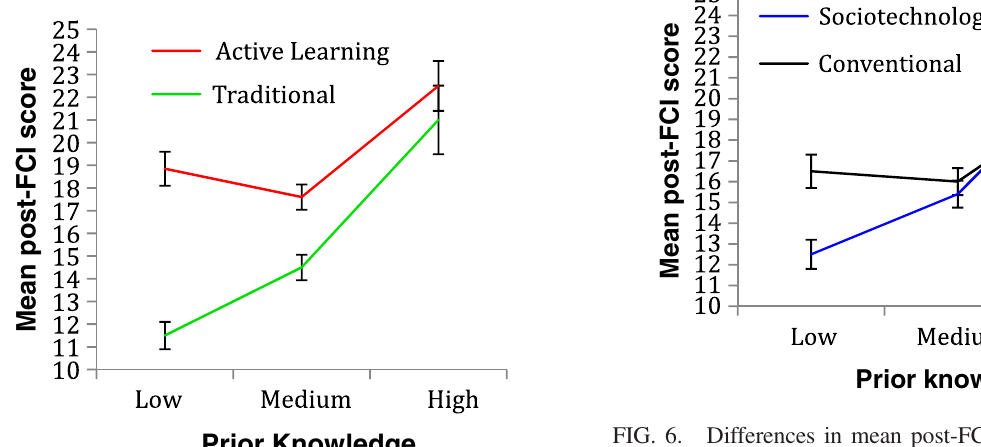
FIG. 6. Differences in mean post-FCI score for students with low, medium, and high prior knowledge in either sociotechno- logical or conventional classrooms. Error bars represent the standard error to the